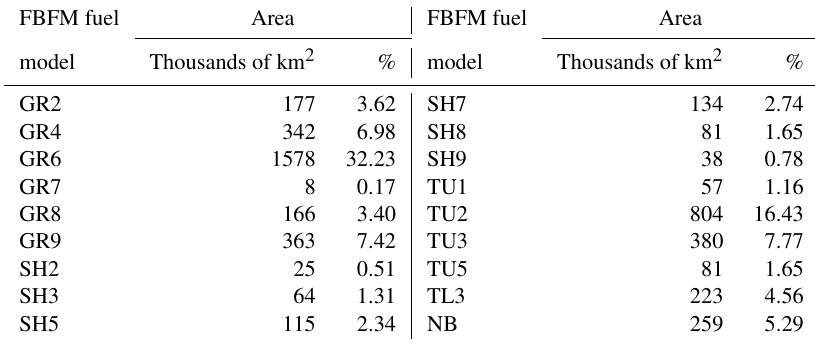
Table C1. Area covered by every FBFM fuel model in the European territory. See Table C2 in Appendix C for the fuel type descriptions and